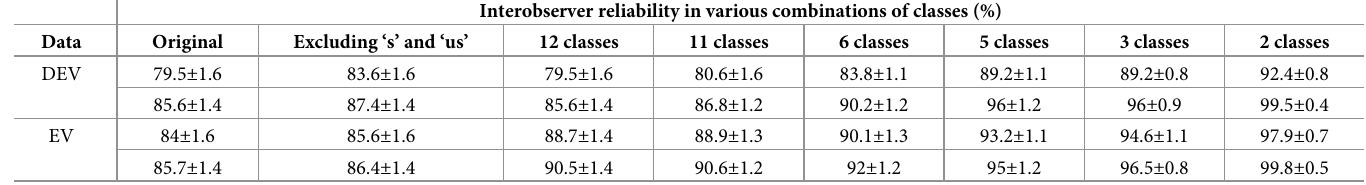
Table 4. Interobserver reliability and resampling-based variance estimation for the subsets of DEV and EV datasets. IOR values (in percentage) are given for different combinations of classes. Two IOR values are presented for each data and each combination of classes: IOR including ‘missed’ segments and IOR excluding ‘missed’